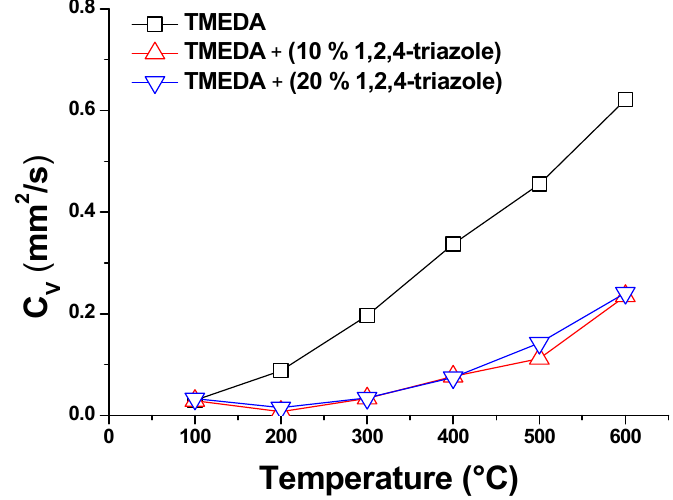
Figure 16. Evaporation coefficients of the TMEDA-based fuels at temperatures of 100–600 °C for the second stage evaporation period.